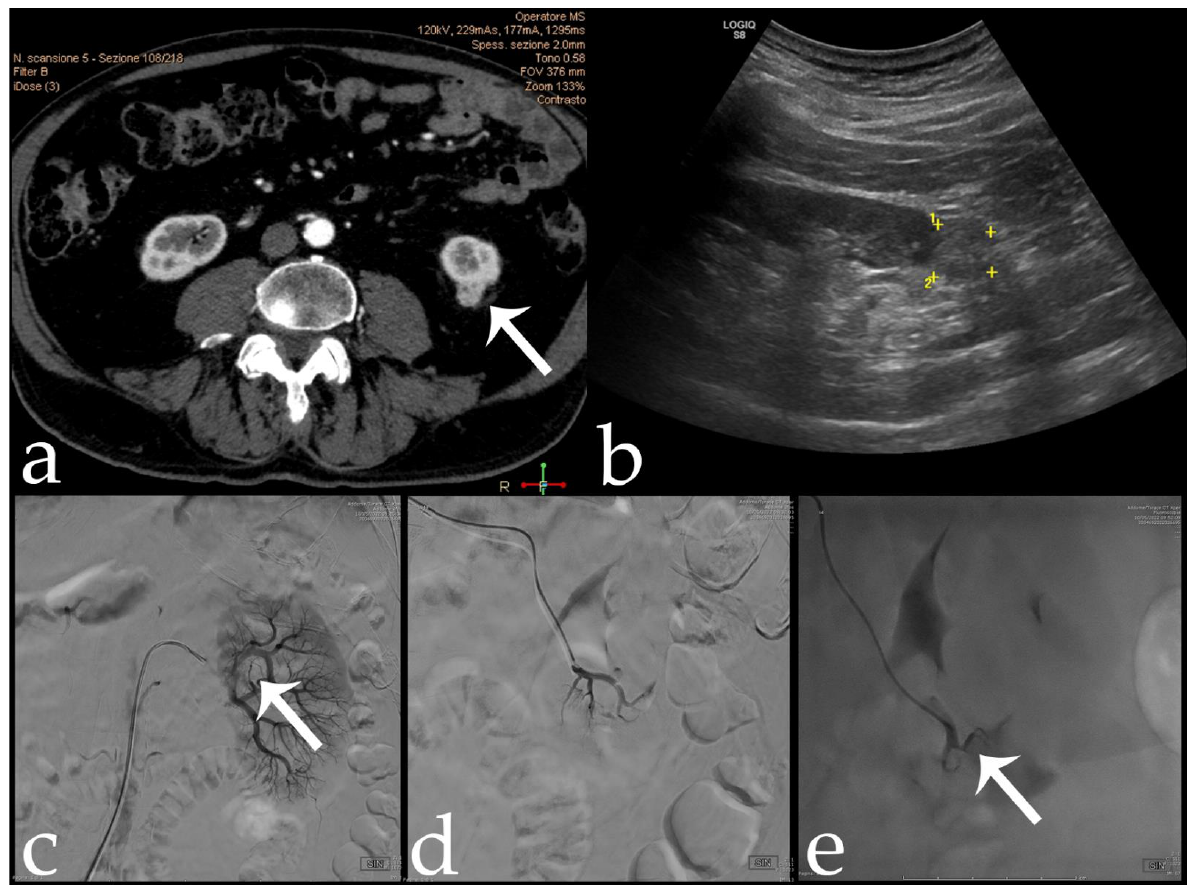
Figure 3. 80 yr old male with intra-cortical RCC of the left kidney lower pole (15 × 15 mm) (arrows): ( a , b ) pre-operative CECT and US; ( c ) pre-embolization angiographic study; ( d , e ) post-embolization control after 18-Onyx and indocyanine mixture administration.